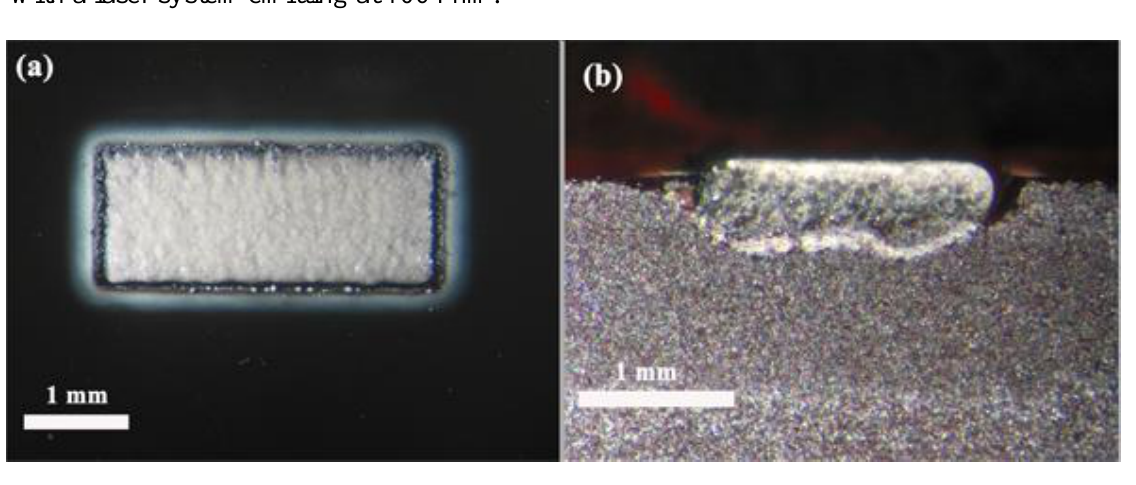
Figure 2. Top view ( a ) and cross-section view ( b ) of the porous layer generated at 600 °C with a laser system emitting at 1064 nm.